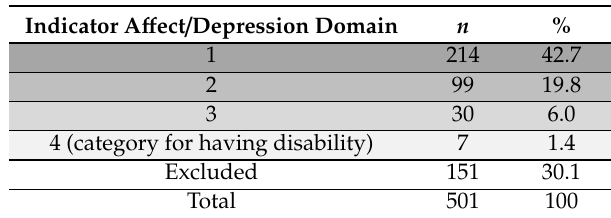
Table 8. Indicator (a ff ect / depression